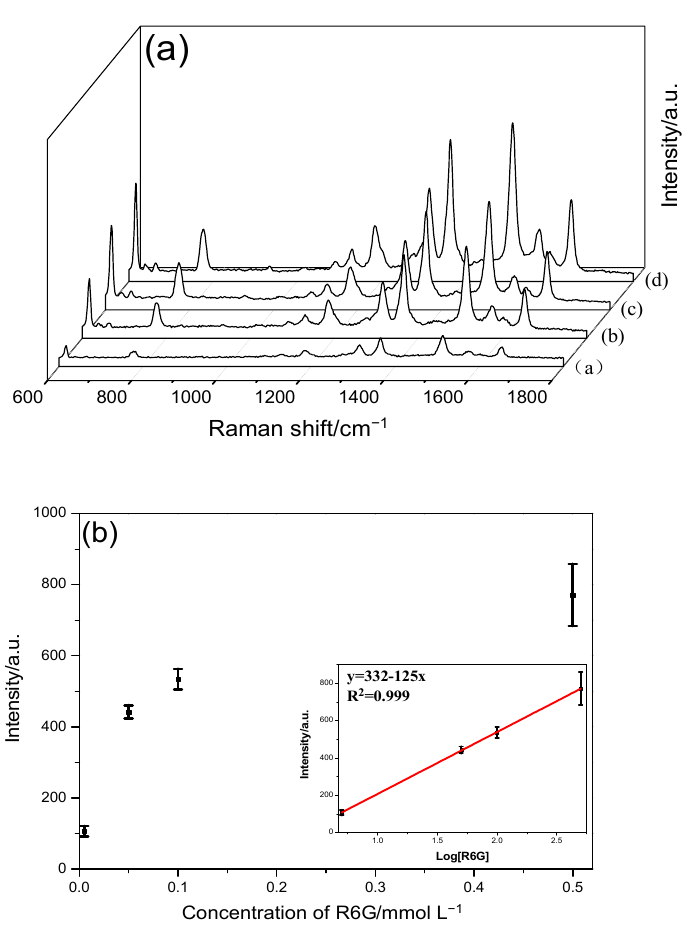
Figure 8. ( a ) SERS spectra of different concentrations of R6G as the model molecule using Au NPs film as the SERS substrate under 633 laser line: 0.005, 0.05, 0.1 and 0.5 mM (a–d), respectively; ( b ) Scatter plots of intensity of SERS spectra at 1511 cm − 1 versus the concentrations of R6G. Inset: Calibration curve of the intensity of SERS spectra versus logarithm of the concentration of R6G.